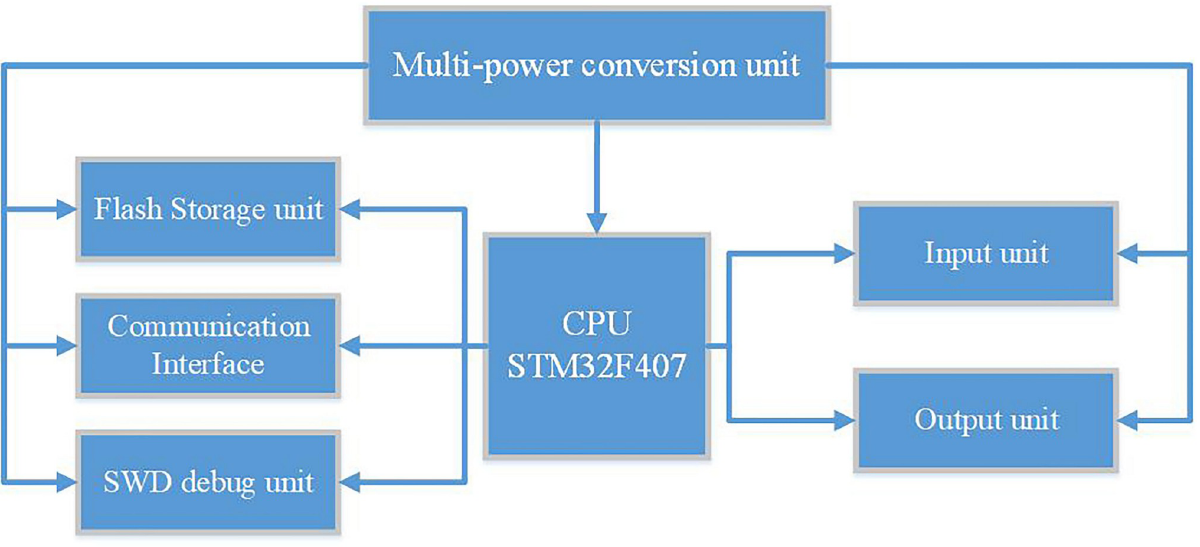
Fig 3. Hardware platform structure of embedded soft PLC control